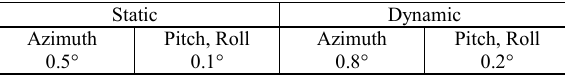
Table 2. Manufacturer's information to IMU Spatial .